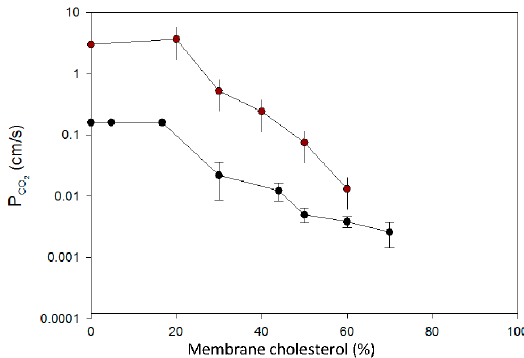
Figure 3. Cholesterol dependency of the CO 2 permeability of phospholipid vesicles. Upper curve: calculated from the molecular dynamics simulation data of Hub et al. [22], lower curve: experimental curve of Itel et al. [3] as shown in Figure 2.